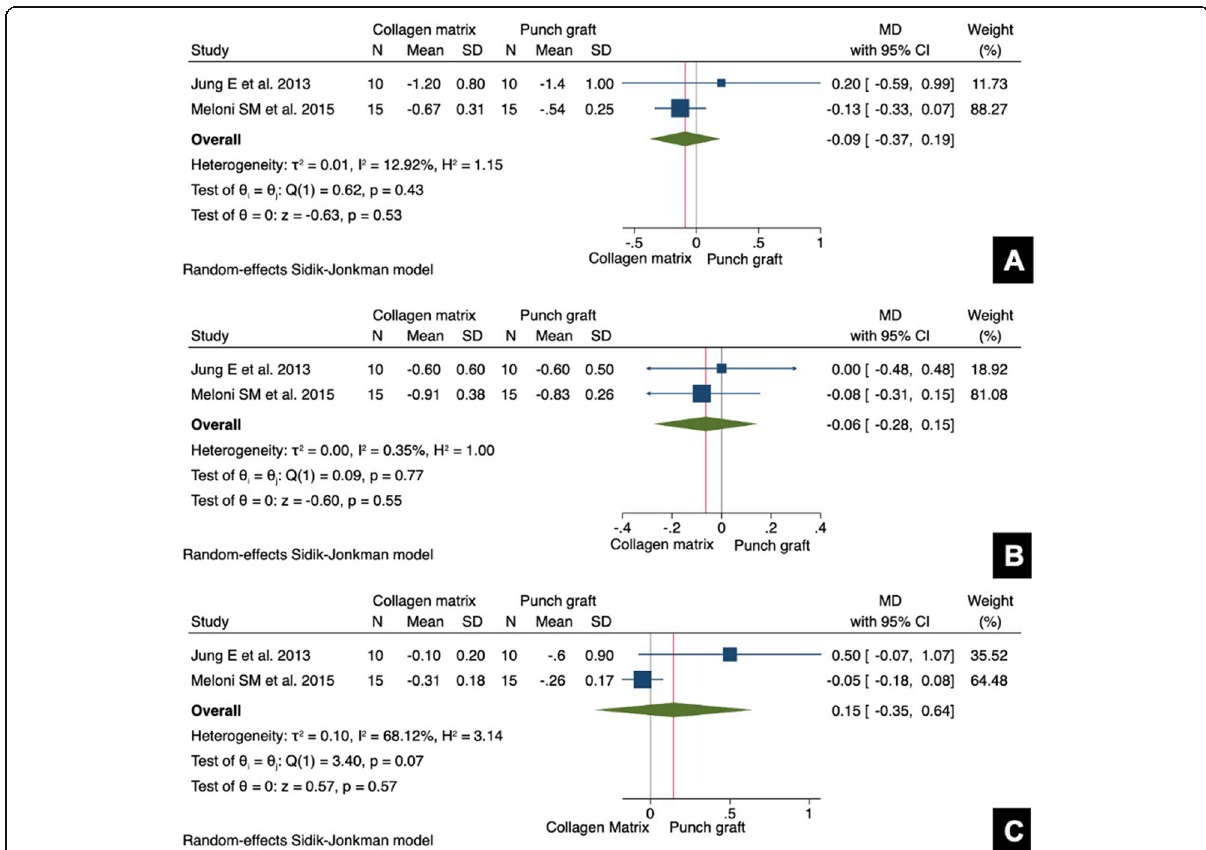
Fig. 3 Forest plots of meta-analyses evaluating alveolar ridge width changes at different cutoff points from the alveolar bone crest. a RW at − 1 mm. b RW at − 3 mm. c RW at − 5